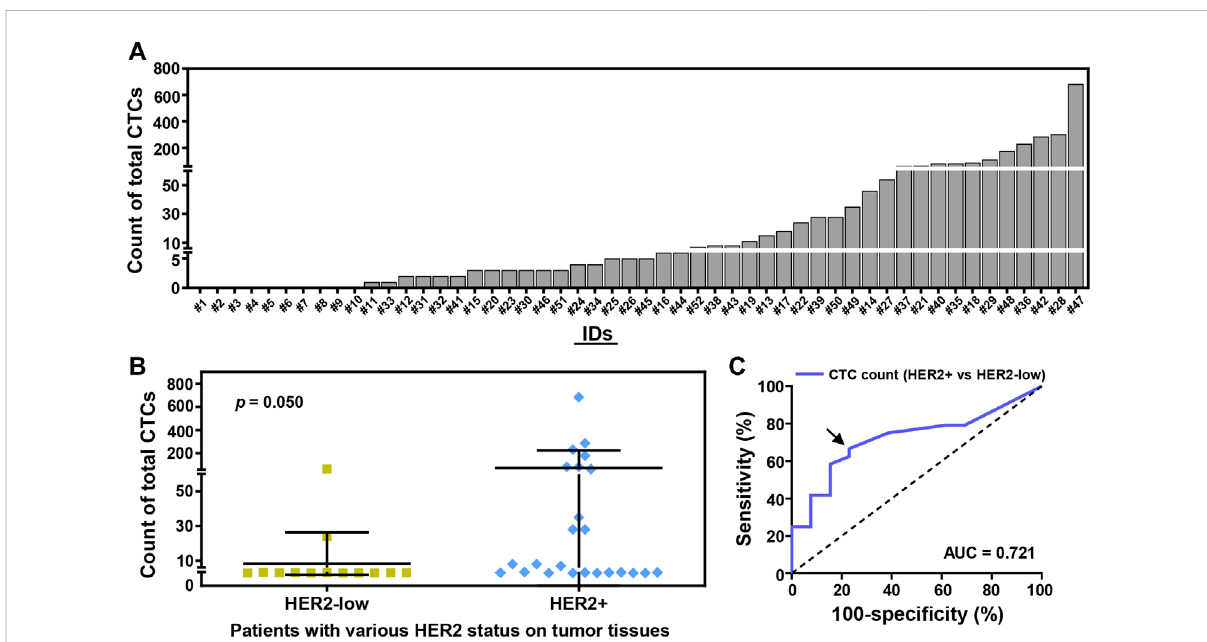
FIGURE 2 CTCenumerationstronglycorrelateswiththeHER2statusofbreastcancerpatientsatbaseline. (A) TotalCTCcountin2.0 mlwholebloodfrom 52 enrolled breast cancer patients (#1 – 52). 42 (52) of the enrolled patients (80.8%) were detected with ≥ 1 CTCs/2.0 ml whole blood. (B) CTC counting of the patients with various HER2 status on tumor tissues by immunohistochemistry (IHC) and/or fl uorescence in situ hybridization (FISH), including HER2-low tumor (IHC+; IHC++ and FISH – ; n = 13), HER2+ tumor (IHC+++; IHC++ and FISH+; n = 24). Data are presented as scattered dots, together with means ± SD. p = 0.050, unpaired Student ’ s t -test with Welch ’ s correction. (C) Receiver operating characteristic (ROC)